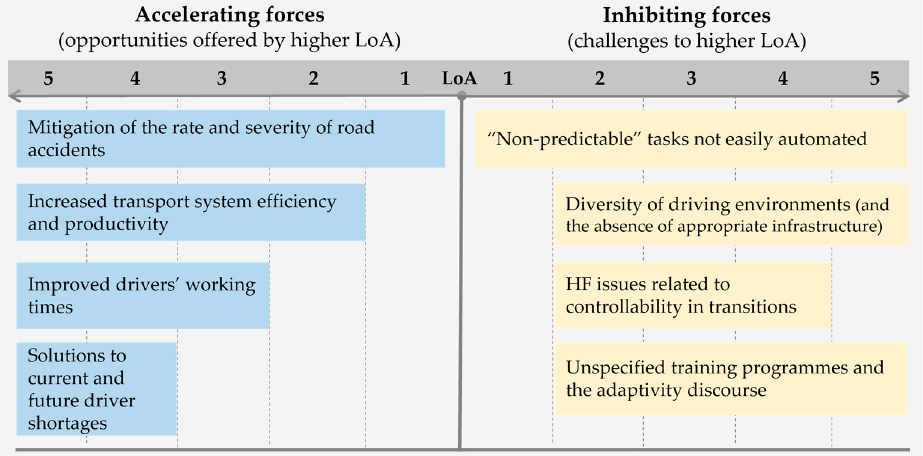
Figure 1. Key “drivers” and “challenges” linked to the implementation of AVs.